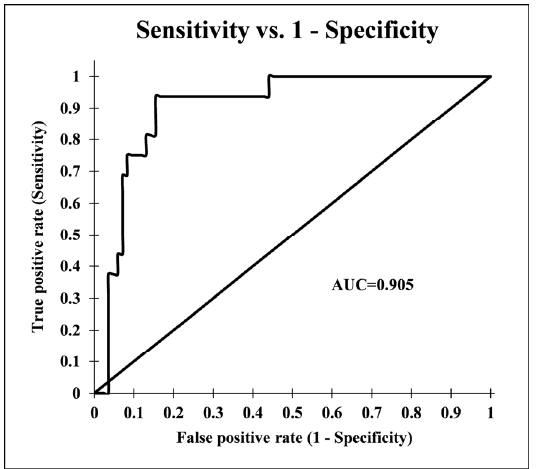
Figure 3 . Receiver operator characteristic (ROC) curve for the habitat suitability map of G. glabra produced by the frequency ratio model.